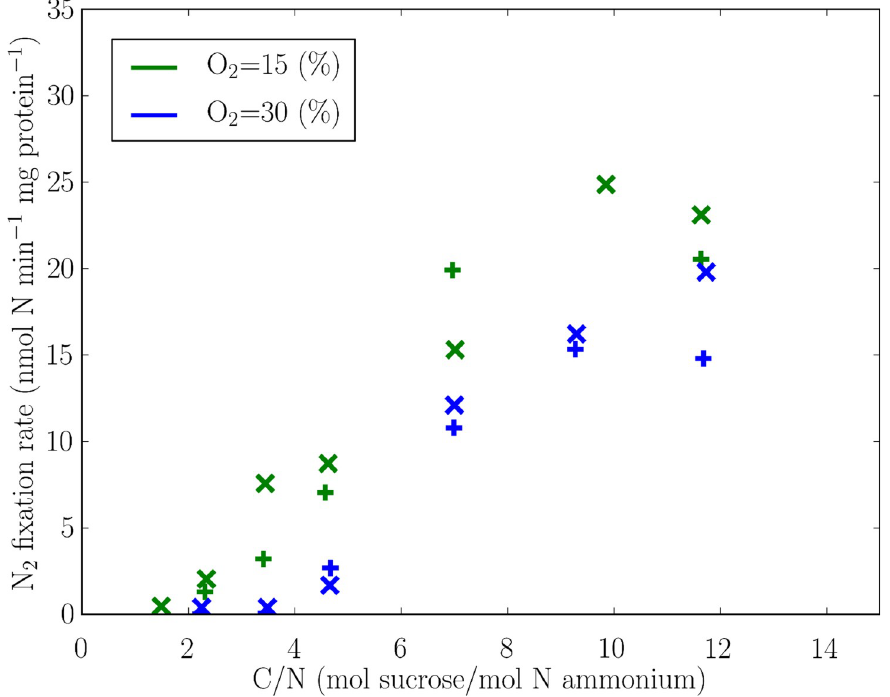
Fig 1. Nitrogen fixation rate per unit protein for various C/N (sucrose/ammonium) supply ratios and two oxygen concentrations in a continuous culture of Azotobacter vinelandii . Dilution rate is 0.15 (h -1 ) with